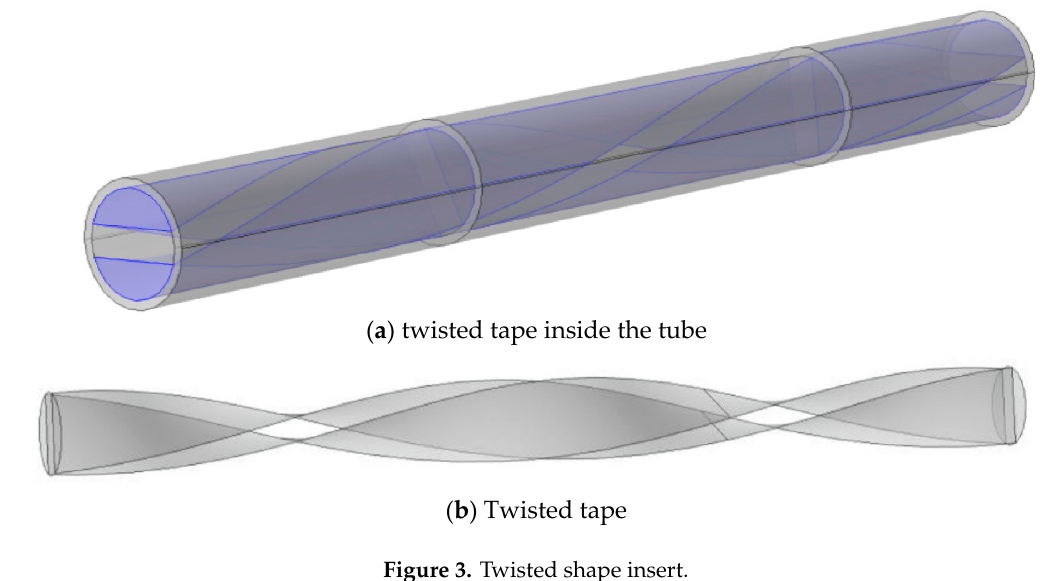
Figure 3. Twisted shape insert.